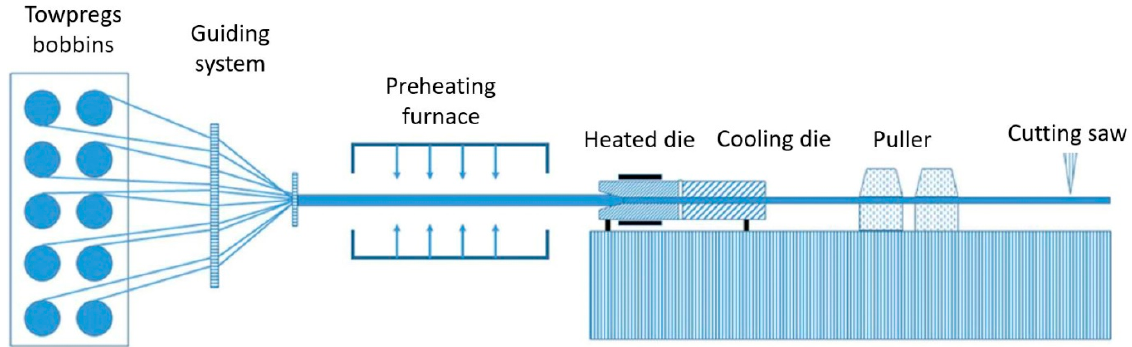
Figure 2. Schematic diagram of the nonreactive thermoplastic pultrusion line. Nonreactive pultrusion machines can also incorporate braiding appliances [101,102].